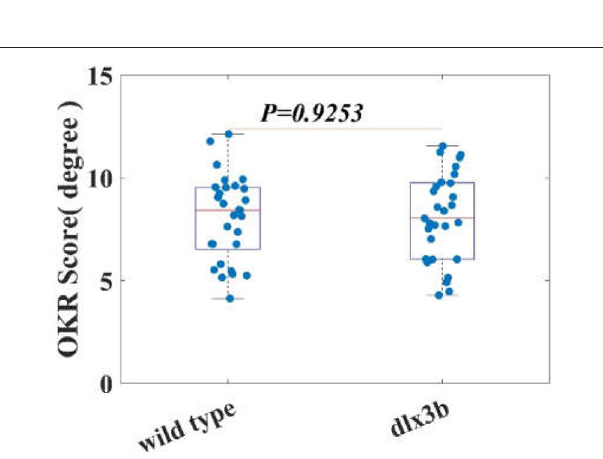
FIGURE 4 | The VOR scores of WT larvae, dlx3b, and dlx4b morphants. The averaged VOR score of WT larvae is significantly higher than that of dlx 3b morphants without the utricular otolith ( Figure 6 ). Although the averaged VOR score of WT and dlx4b morphant larvae is not statistically different, all VOR score data points dlx4b morphants are more variable.